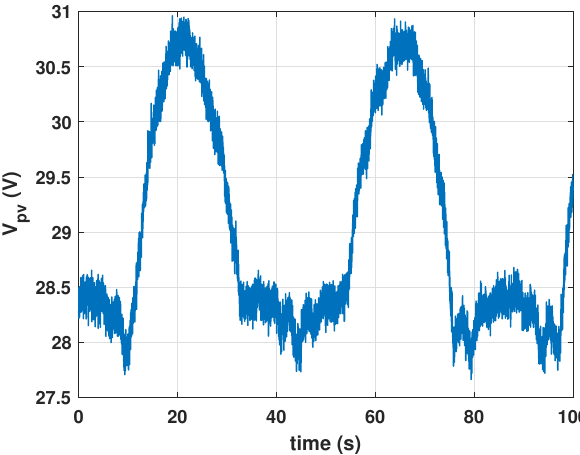
Figure 14. Output voltage of the PV emulator.